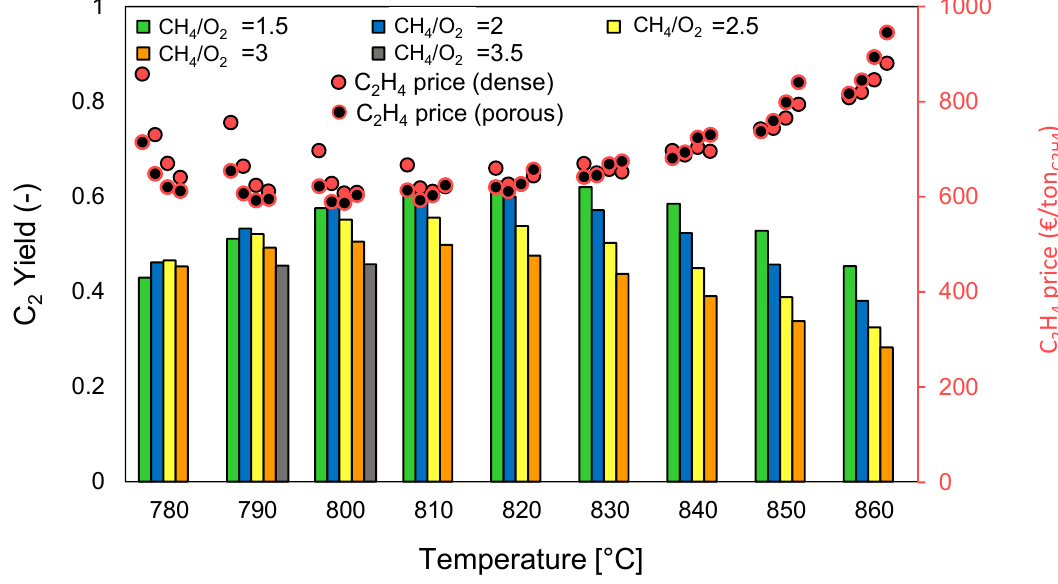
Figure 3. OCM reactor yield at different reactor temperatures and operating CH 4 /O 2 ratios (valid for both porous and dense membrane reactor cases represented with bars), and overall C 2 H 4 price obtained based on the process scheme for the porous and the dense membrane reactor cases.